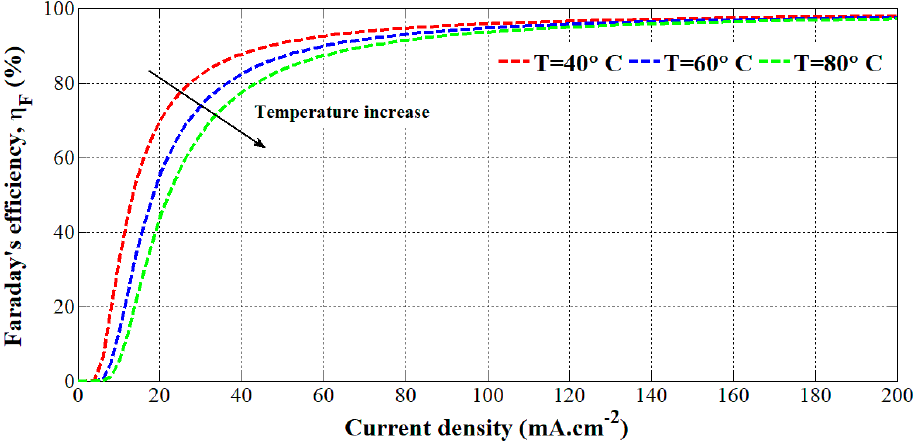
Figure 1. Faraday’s efficiency according to the current density at different temperatures.